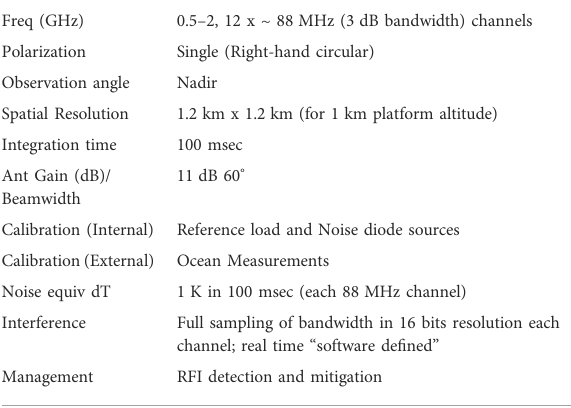
TABLE 2 UWBRAD instrument Parameters.